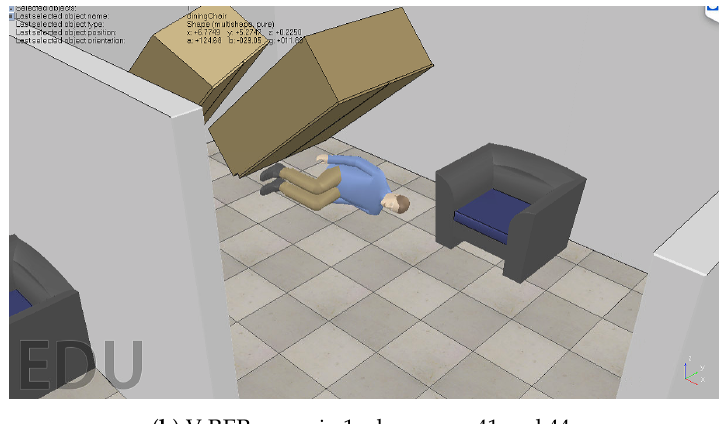
Figure 17. Clipping of hexagons 41 and 44 of Figure 16.